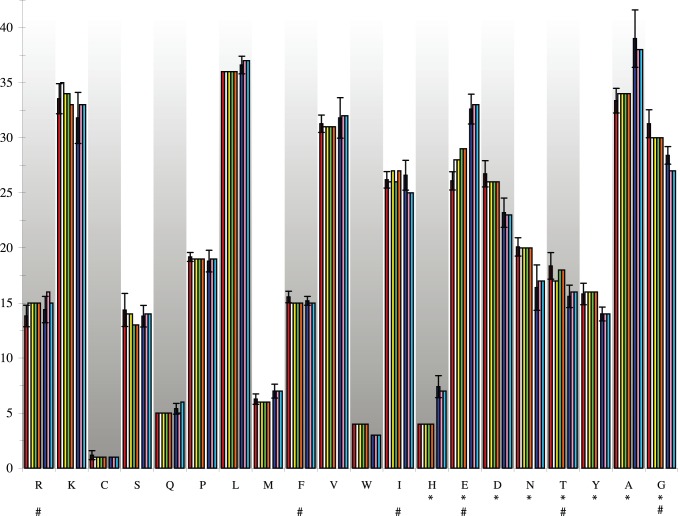
Comparison of amino acid compositions between Thermococcus sequences and Thermotoga sequences.The y-axis is amino acid (AA) counts and the x-axis is the amino acid. Red bars are the mean of the extant Thermotoga sequences; white, yellow, green and orange bars are the Thermotoga ancestral reconstructed sequences ATM_T1–T4, respectively. Dark blue bars are the mean archaeal sequences, and pink and light blue bars are the Thermococcus ancestral reconstructed sequences ACM_C1–C2, respectively. A (*) marks where there is a significant difference (p<0.01) in the AA counts between the Archaea and the Thermotoga. A (#) marks where there is a significant difference between the extant Thermotoga sequences and the reconstructed Thermotoga sequences. This shows there is no significant difference between the Thermococcus extant sequences and the Thermococcus ASR sequences, see Table S4 for p-values.